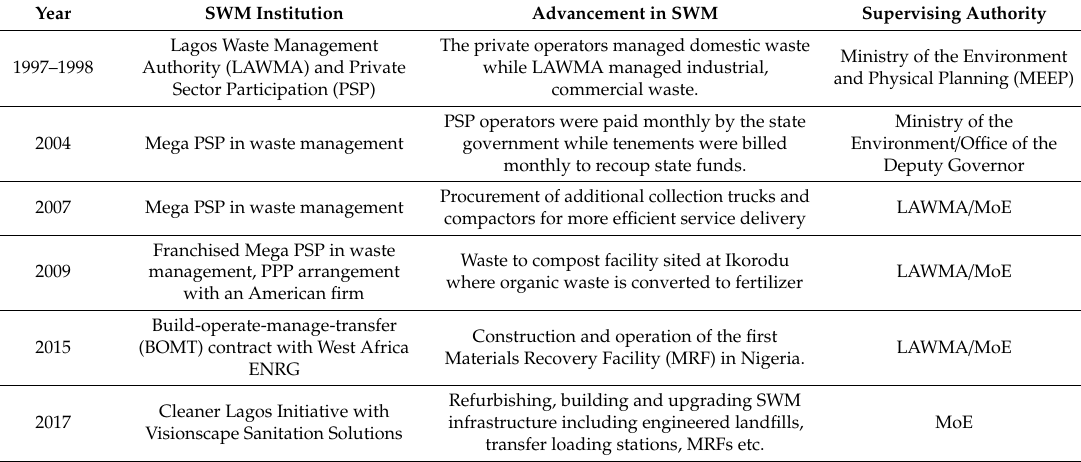
Table 2. History of private sector involvement in SWM in Lagos